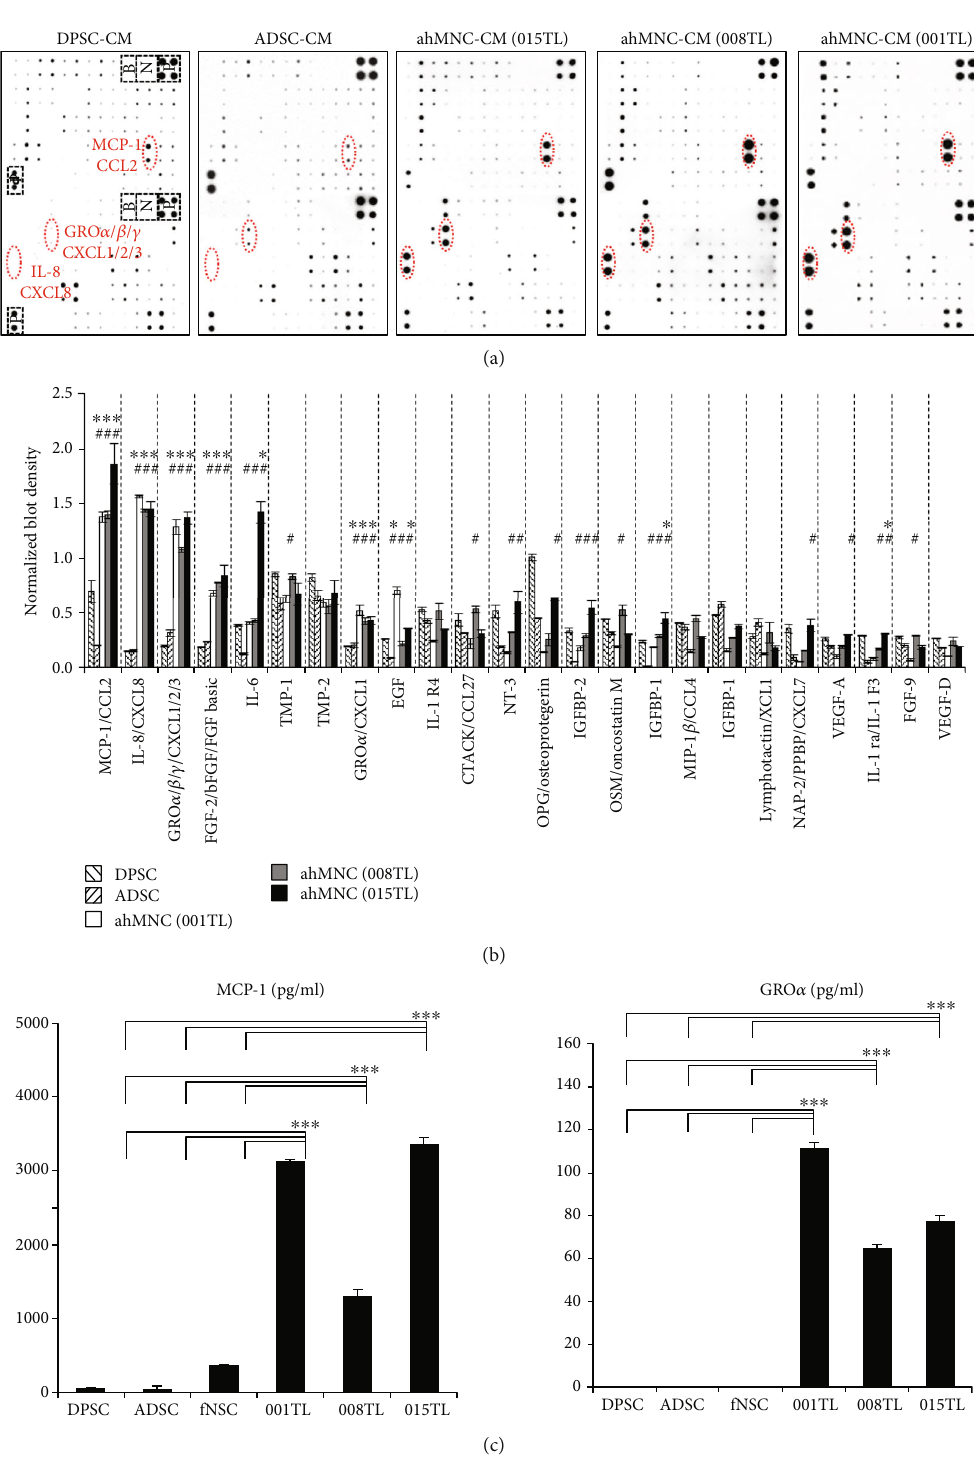
Figure 5: Paracrine factors of ahMNCs. (a) 120 paracrine factors of ahMNCs, DPSCs, and ADSCs were analyzed by cytokine array. (b) Cytokines whose levels were within top 20% in the CM of ahMNCs were illustrated and compared with those of DPSCs and ADSCs. Height = average , error bar = SD . ∗ and # indicate signi fi cantly higher level of cytokine in ahMNCs compared to DPSCs and ADSCs, respectively. ∗ P < 0 : 01 and # P < 0 : 05 . (c) Protein levels of MCP-1 and GRO α in CM were analyzed by ELISA and then compared. Height = average , errorbar = SD . ∗∗∗ P < 0 : 01